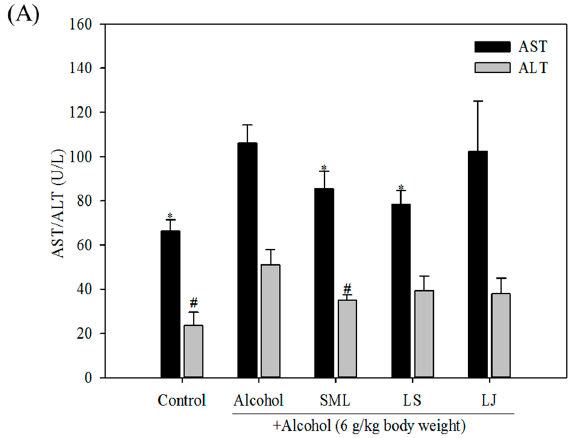
Figure 3. Cont. Figure 3.